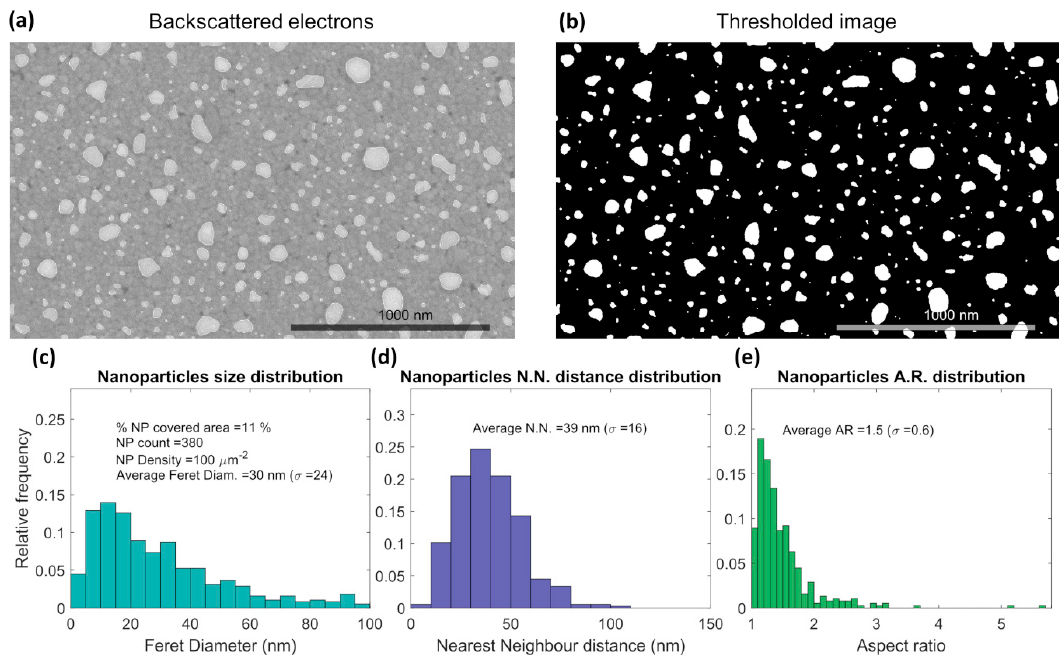
Figure 6. Au-Ag nanoparticle distribution analysis, using a MATLAB algorithm: ( a ) top-view SEM micrograph with atomic weight contrast and ( b ) processed and threshold micrograph showing the exposed Au-Ag nanoparticles, with 11% Au-Ag coverage area. Distribution histograms are displayed in ( c ) for nanoparticles Feret diameter, ( d ) for the nearest neighbor distance, and ( e ) for the aspect ratio.